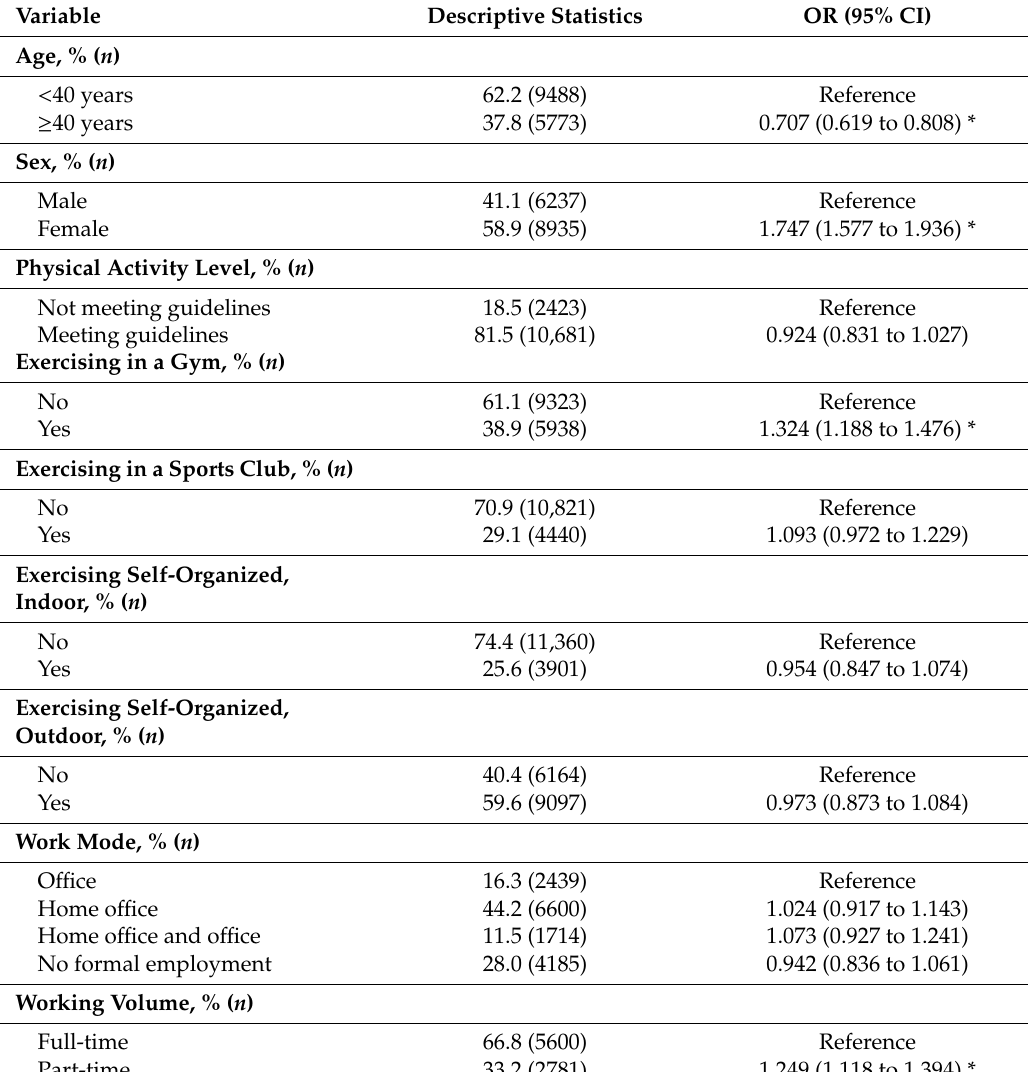
Table 1. Variables associated with willingness to participate in online home exercise